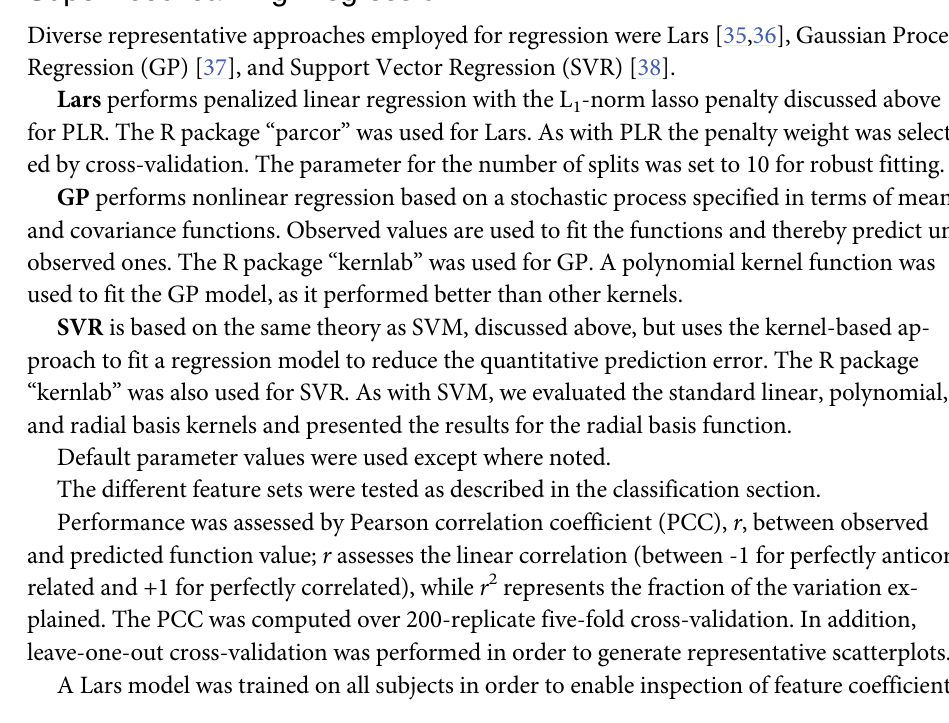
S2 Fig. Classification of ADCC from antibody features by penalized logistic regression. (A-F) Prediction results by 200-replicate five-fold cross-validation, illustrating PLR values ( > 0.5 predicted high ADCP; < 0.5 predicted low) for one replicate (A,C,E) and providing area under the ROC curve (AUC) over all 200 replicates (B,D,F). Box & whisker plots show the me- dian (thick center line), upper and lower quartiles (box), and 1.5 times the interquartile range (whiskers); all points are also plotted in a jittered stripchart. Colors for the classification exam- ples indicate high (red) and low (blue) observed ADCP. (G-I) Coefficients and p-values of